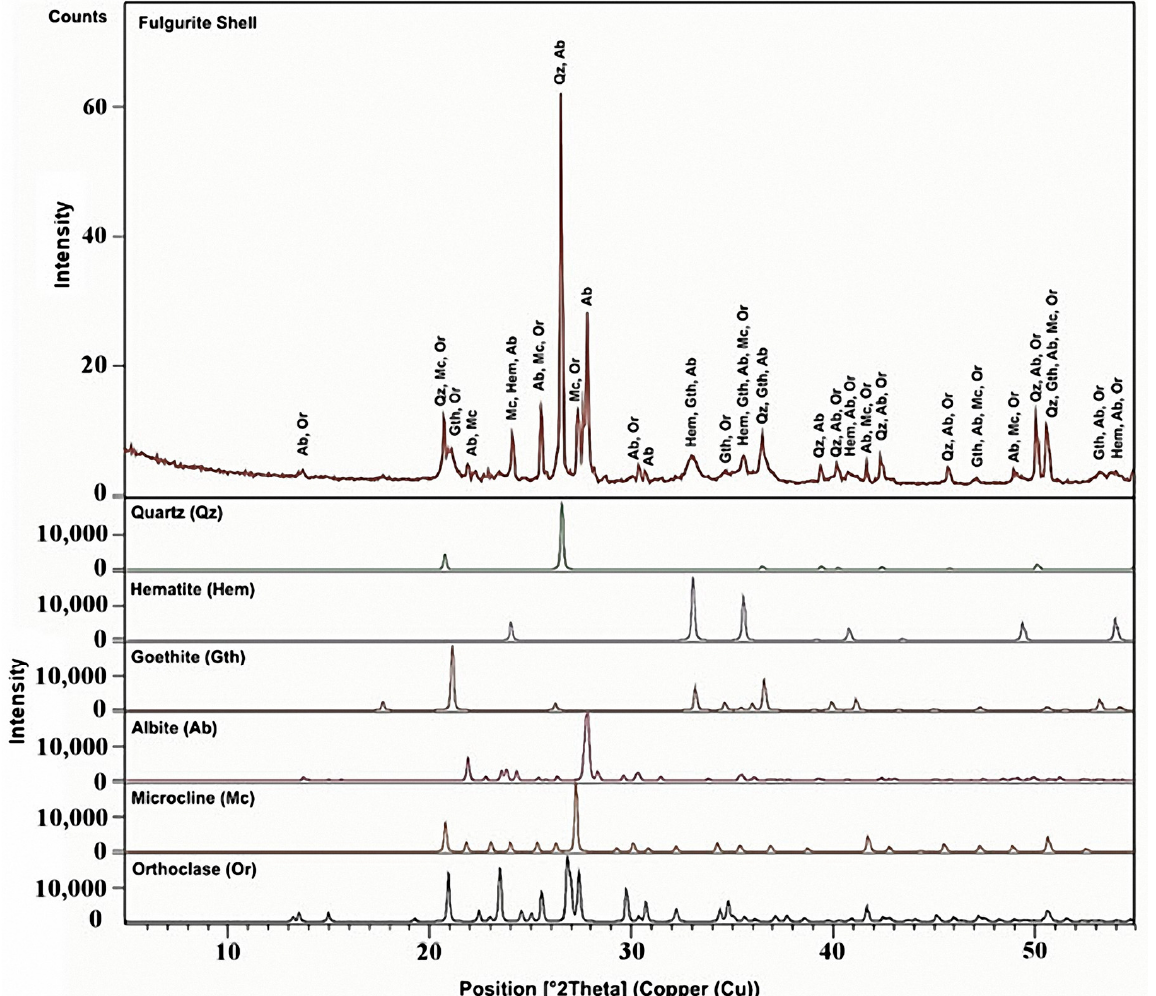
Figure 12. X-ray powder diffraction pattern of the fulgurite core sample. Qz: quartz; Hm: hematite; Gth: goethite; Ab: albite; Mc: microcline; Or: orthoclase. The observed diffractogram of the sample corresponds to the red line shown in the top panel of the figure, while the separate contributions of the